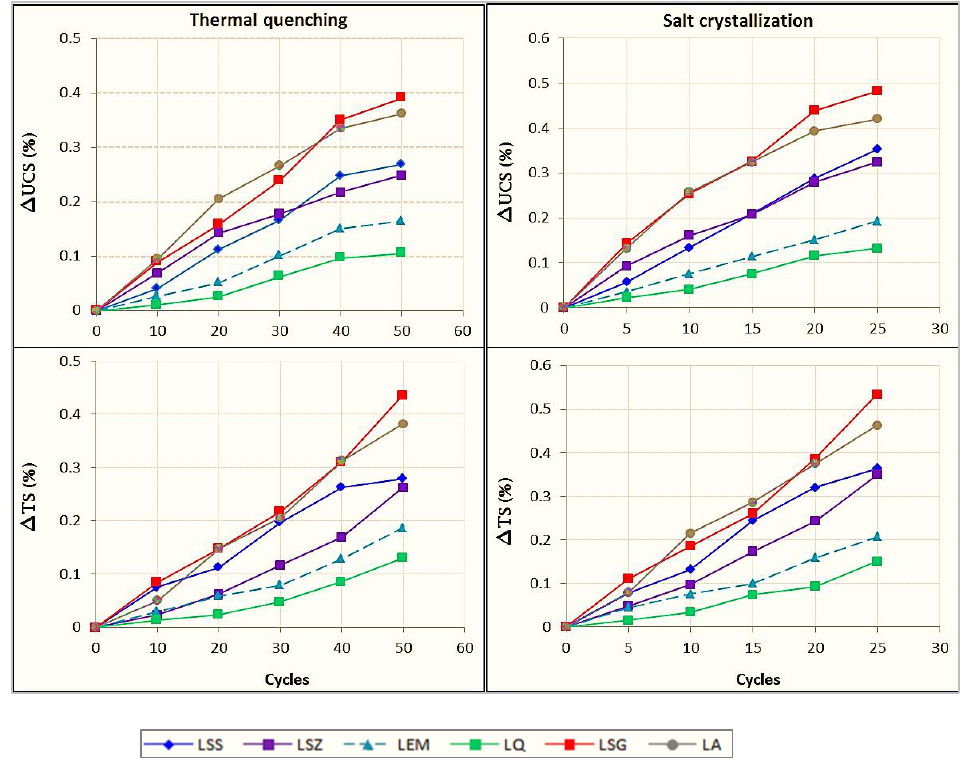
Figure 7. Change rate of TS and UCS values due to the cyclic thermal quenching and salt crystal- lization.